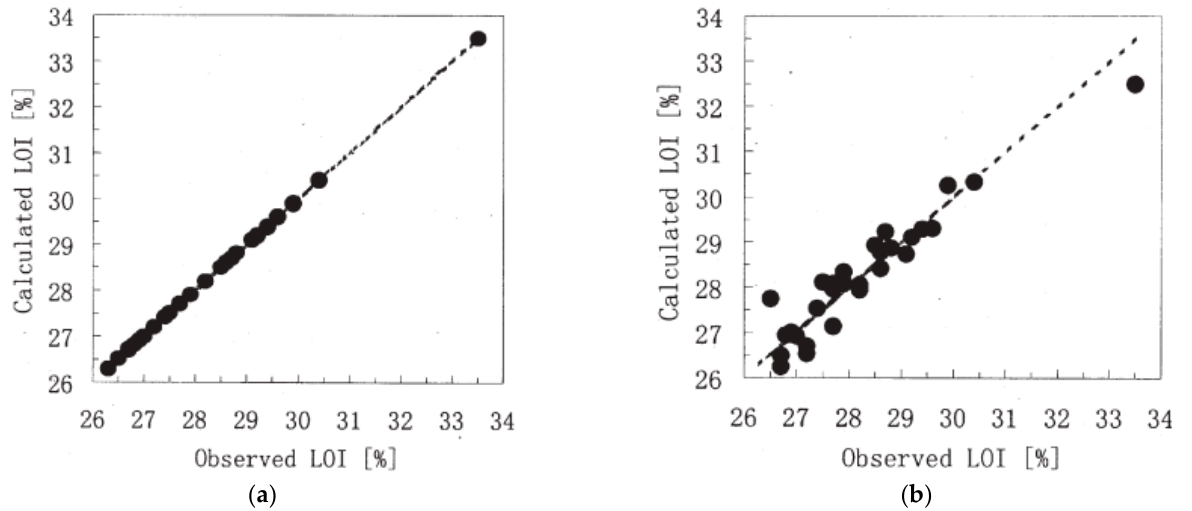
Figure 9. The schematic of the backpropagation network for the polyamide-66 (PA-66) formulation design model to predict the limiting oxygen index (LOI) value. Adapted with permission from ref. [101]. Copyright 2001 Journal of Fire Sciences.